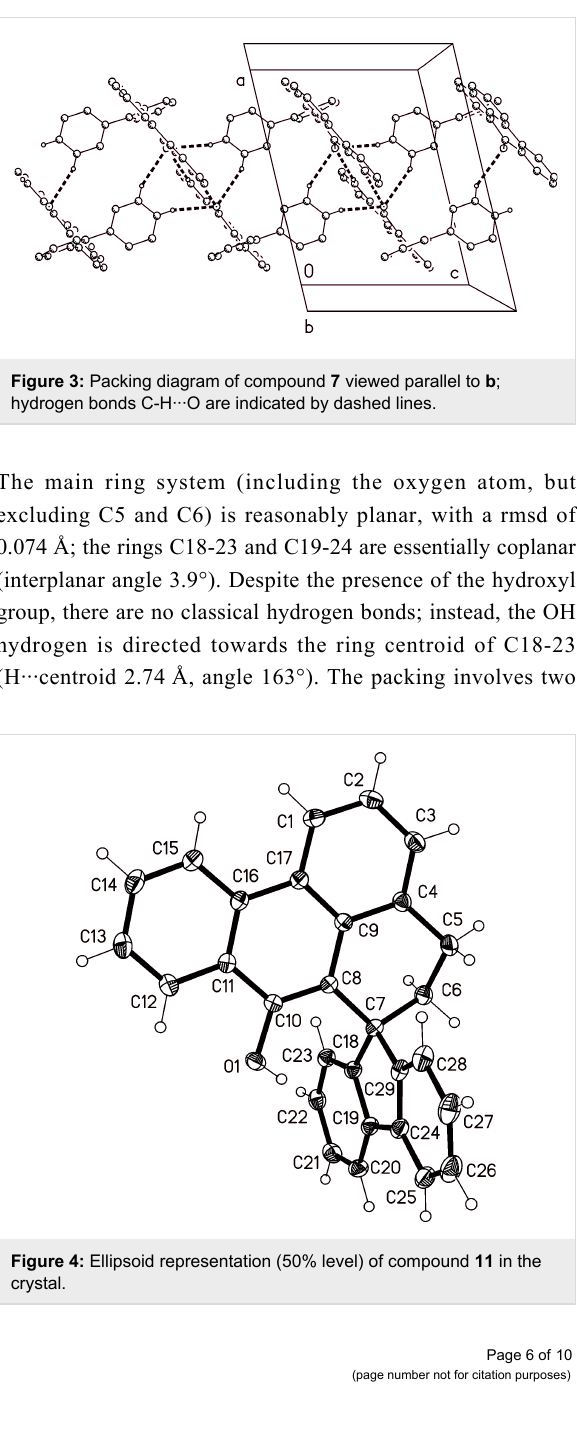
Figure 4: Ellipsoid representation (50% level) of compound 11 in the crystal.